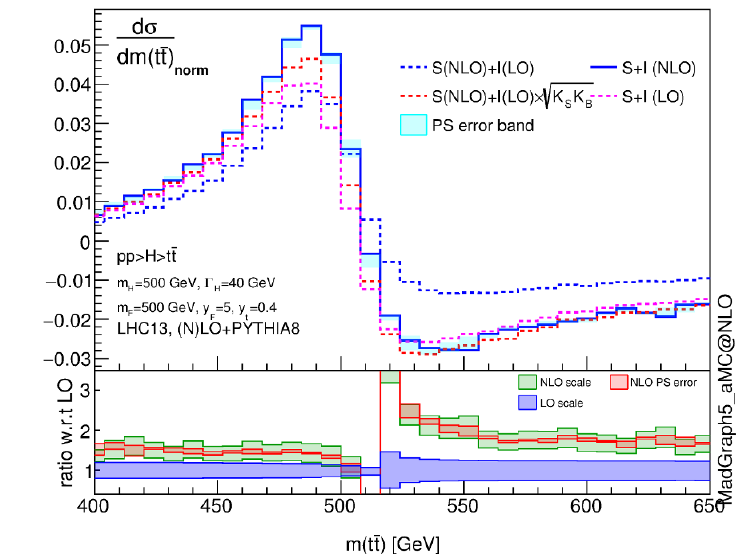
Figure 13 . Total BSM e(cid:11)ects (signal+interference) with the interference at LO/NLO, at the LHC 13 TeV matched to PS. Results are normalised to the SM fNLO lineshape, except for the LO curve which is normalised to SM fLO. The lower panel displays the K-factors and the scale uncertainties of signal and interference